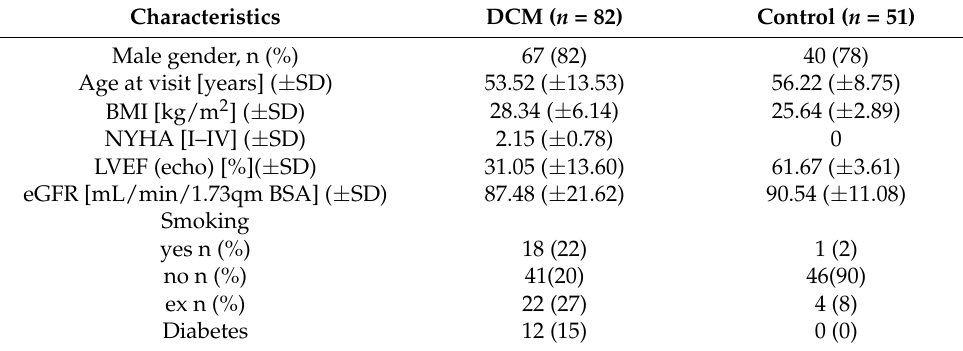
Table 1. Patient characteristics of the stage 1